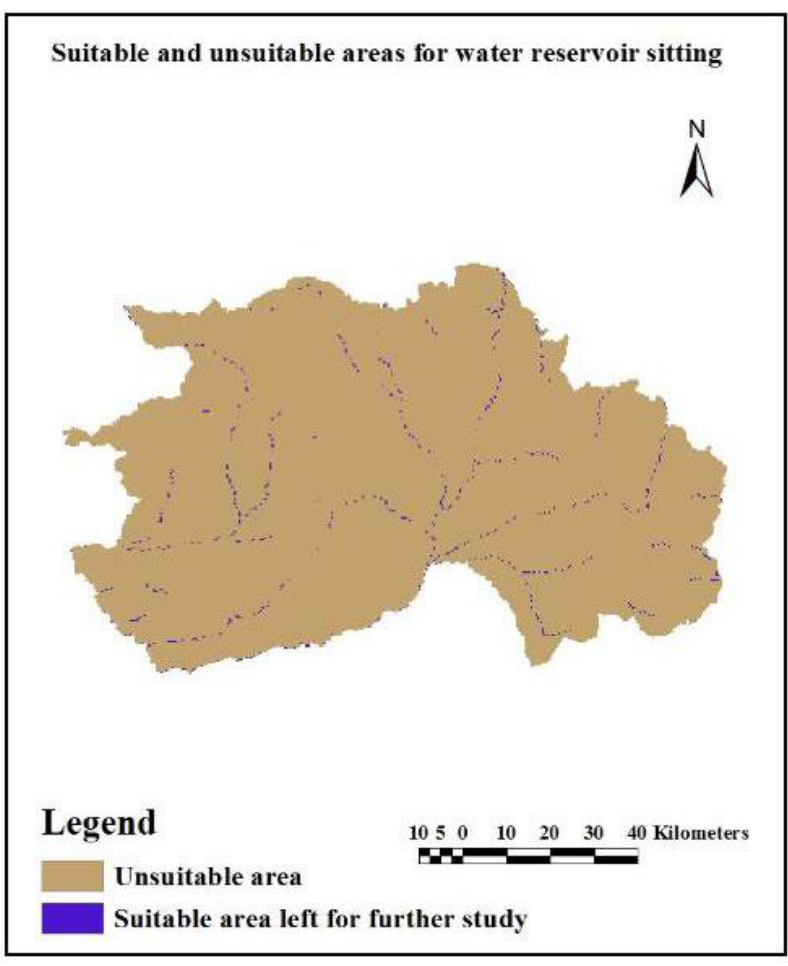
Figure 4. Areas excluded from water reservoir